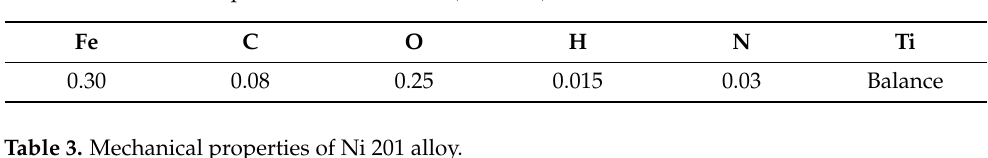
Table 2. Chemical composition of Ti Grade 2 (in wt. %).